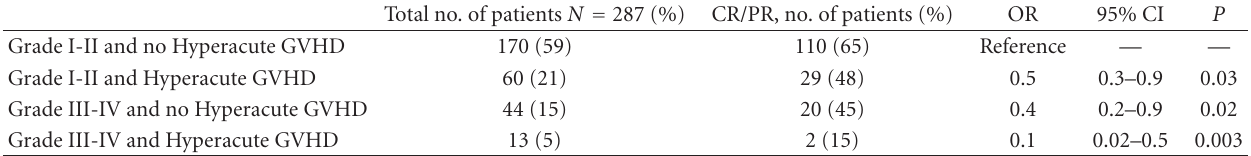
Table 3: E ff ect of severity and time of onset of aGVHD on response.